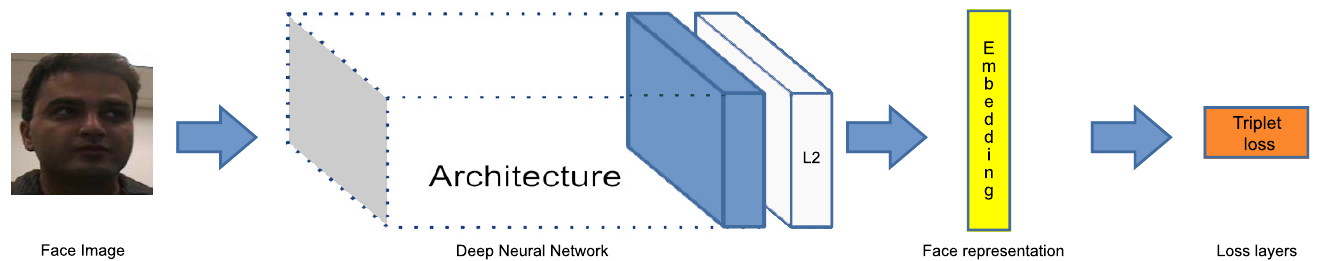
Figure 1. An overview of the FaceNet [48]